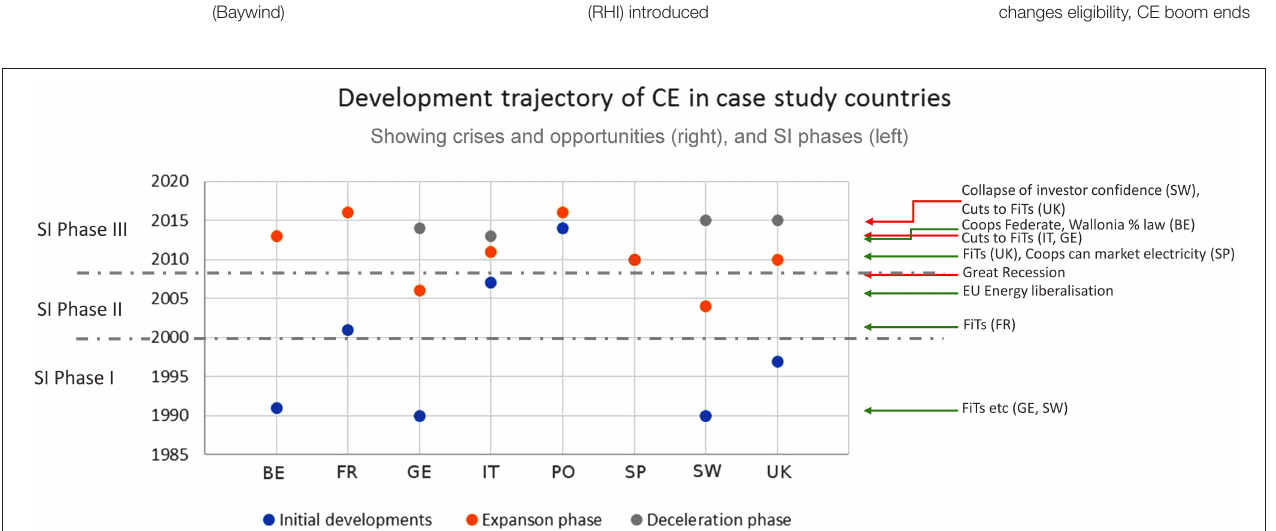
FIGURE 10 | Development trajectory of CE in case study countries, showing crises and opportunities (Right) and SI phases